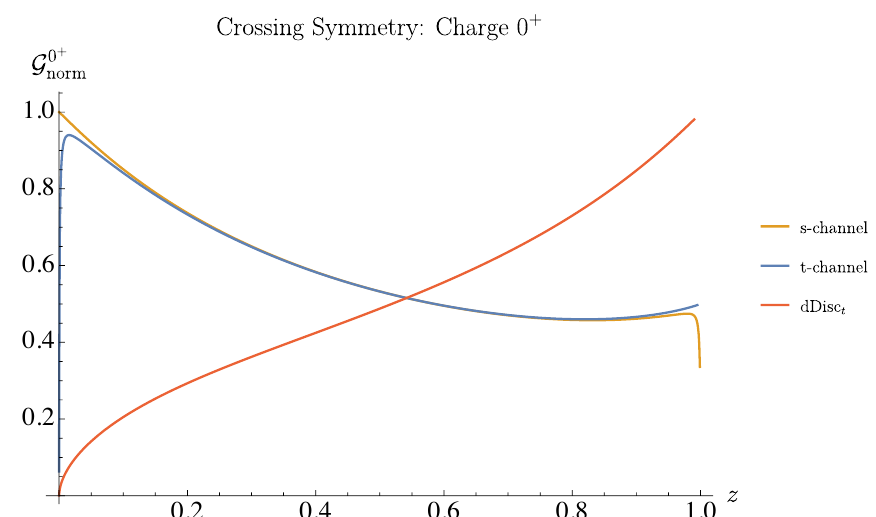
Figure 18 . We study the correlator h (cid:30)(cid:30)(cid:30)(cid:30) i and project onto 0 + exchange in the s -channel. We plot the prediction for G 0 + ( z; z ) using the s and t -channel OPEs. We also plot its dDisc t , which norm we compute by expanding in the t -channel OPE and then taking the double-discontinuity. We normalize all three functions by an MFT four-point function. Because dDisc t is computed using the t -channel OPE, it is reliable where the t -channel OPE is reliable. This includes the region z > 1 = 2 and also somewhat smaller z & 0 : 1 where crossing symmetry holds to high